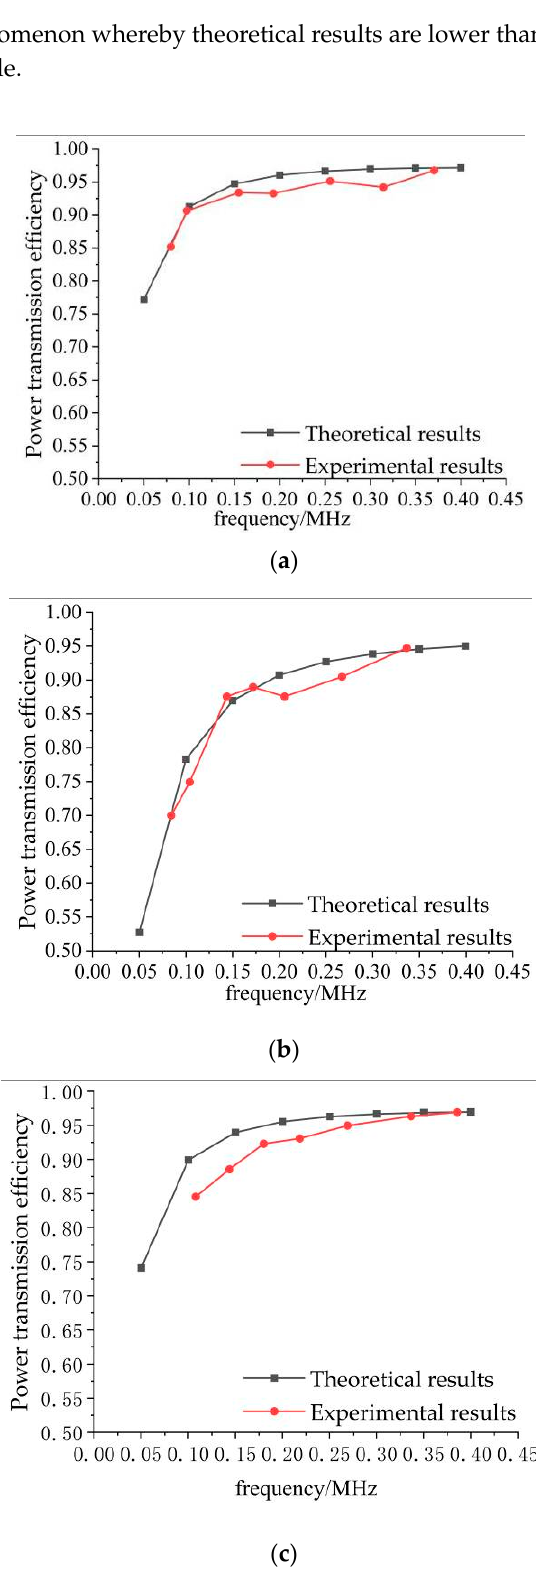
Figure 11. The power transmission efficiency changes with the resonance frequency: ( a ) the WPT system without shielding coils; ( b ) the series-opposing structure WPT system; ( c ) the inductive structure WPT system.